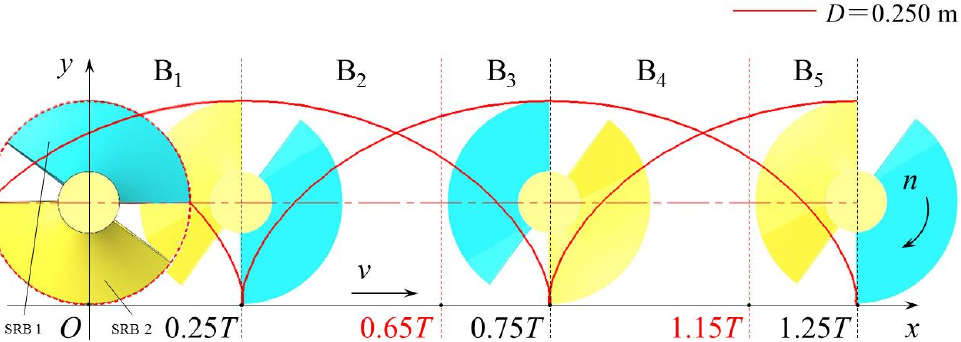
Figure 7. The trajectory of the tip of the SRB when D = 250 mm. Note: D is the ODRD, mm; n is the RVSS, rpm; v is the operating velocity of machines, km/h. In order to describe the motion law of the SSM more clearly, the two sets of SRB in green are expressed as the blue SRB 1 and the yellow SRB 2.